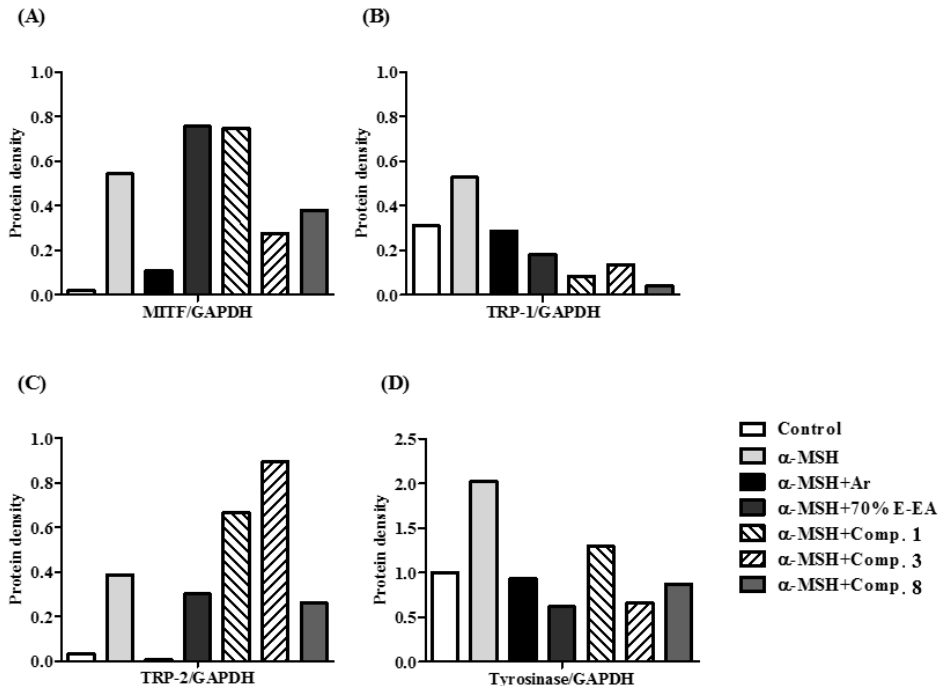
Figure 5. Effects on melanogenesis-related protein expression in α -MSH-induced murine B16-F10 cells; B16-F10 cells were pretreated with test samples for 2 h and α -MSH was added to the cells for 24 h. Glyceraldehyde 3-phosphate dehydrogenase (GAPDH) was used as the control protein. The protein levels of microphthalmia-associated transcription factor (MITF), tyrosinase, tyrosinase-related protein-1 (TRP-1), and tyrosinase-related protein-2 (TRP-2) were detected by Western blot analysis. Compounds 3 and 8 significantly reduced the expression of MITF, tyrosinase, TRP-1, and TRP-2 in α -MSH-induced B16-F10 cells. Arbutin, a positive control drug, also blocked the melanogenesis. ( A ) MITF, ( B ) TRP-1, ( C ) TRP-2, and ( D ) tyrosinase were analyzed and quantified using Azure Spot software. MITF, TRP-1, TRP-2 and tyrosinase protein levels were normalized by GAPDH.